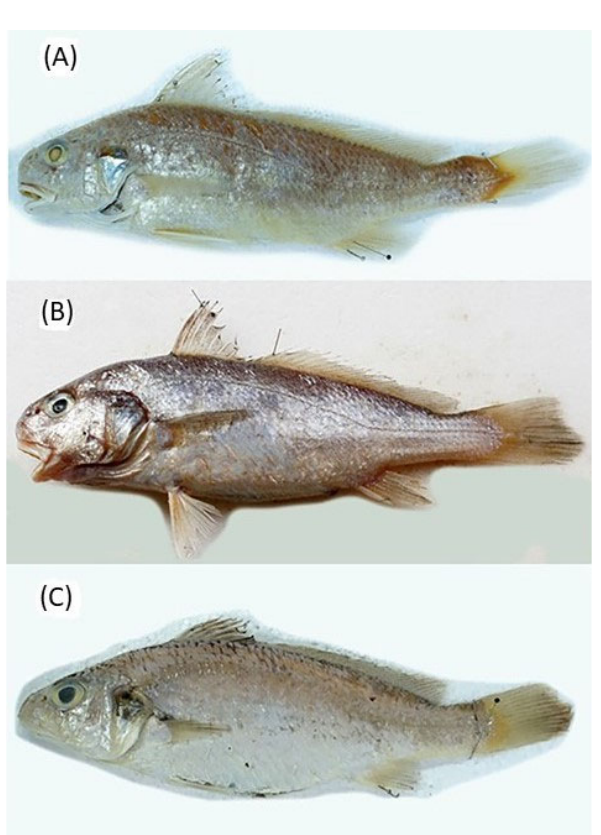
Figure 6. Photographs of Johnius species here described, with specimens deposited in the Taiwan National Museum Marine Biology and Aquarium (NMMBA). ( A ) Johnius grypotus NMMB ‐ P23015, 140.22 mm SL; ( B ) Johnius taiwanensis NMMB ‐ P37073, 122.62 mm SL; and ( C ) Johnius trewavasae NMMB ‐ P37071, 117.42 mm SL. Diagnosis . Steep snout, obtusely rounded; mouth inferior; gill rakers slender, long, more than 1/2 length of gill filaments at angle of arch, 11 to 12 on lower limb of first gill arch; caudal fin pointed; scales very deciduous, scales small, 5 to 6 scale rows above lateral line. Description. Small ‐ sized species with moderately deep body; body depth 26.8 to 29.4% of standard length. Eye large, 21.9 to 26.4% of head length. Interorbital width 27.3